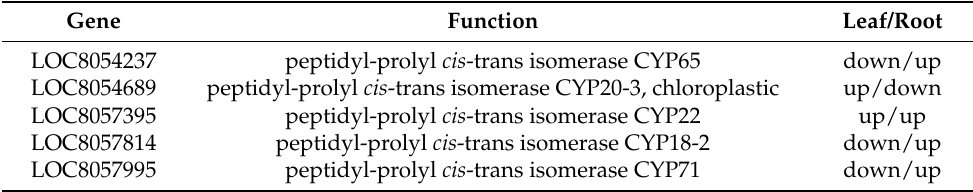
Table 4. List of Nampungchal DEGs associated with stress-responsive